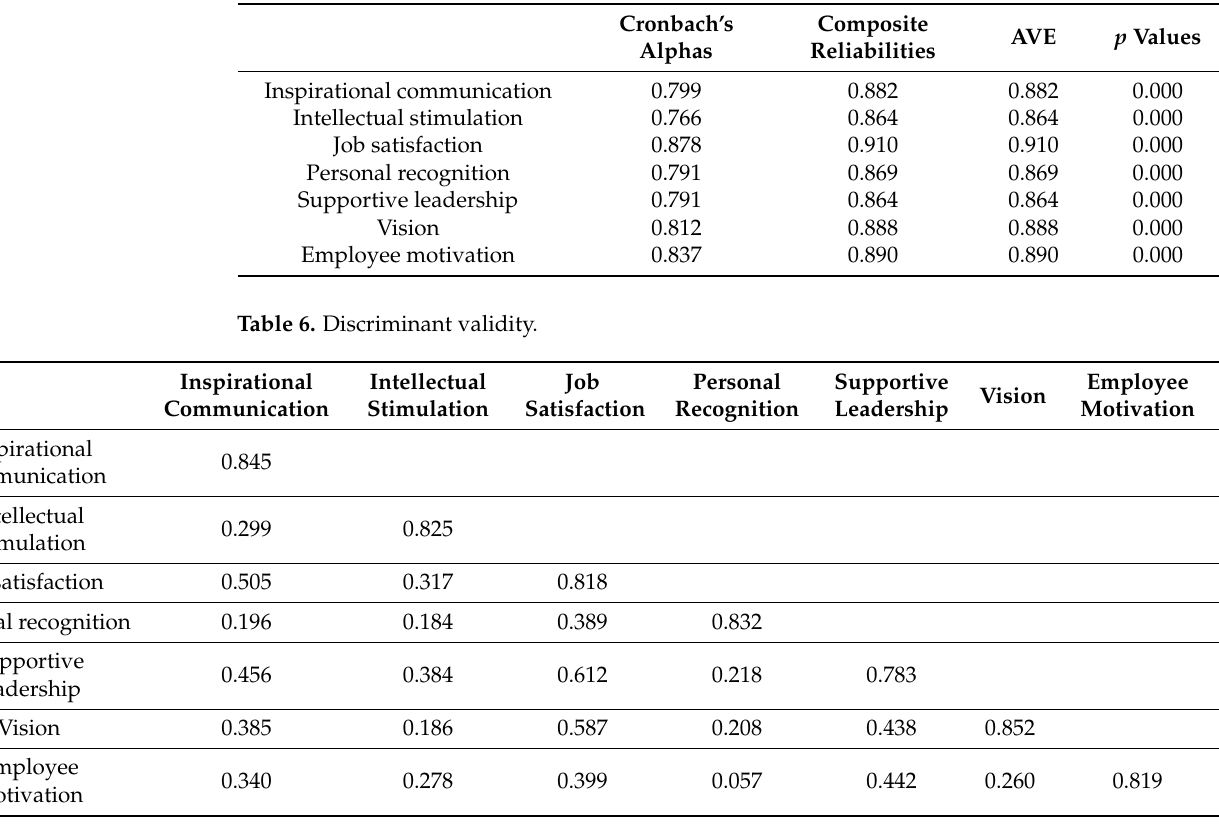
Table 5. Convergent validity analysis.